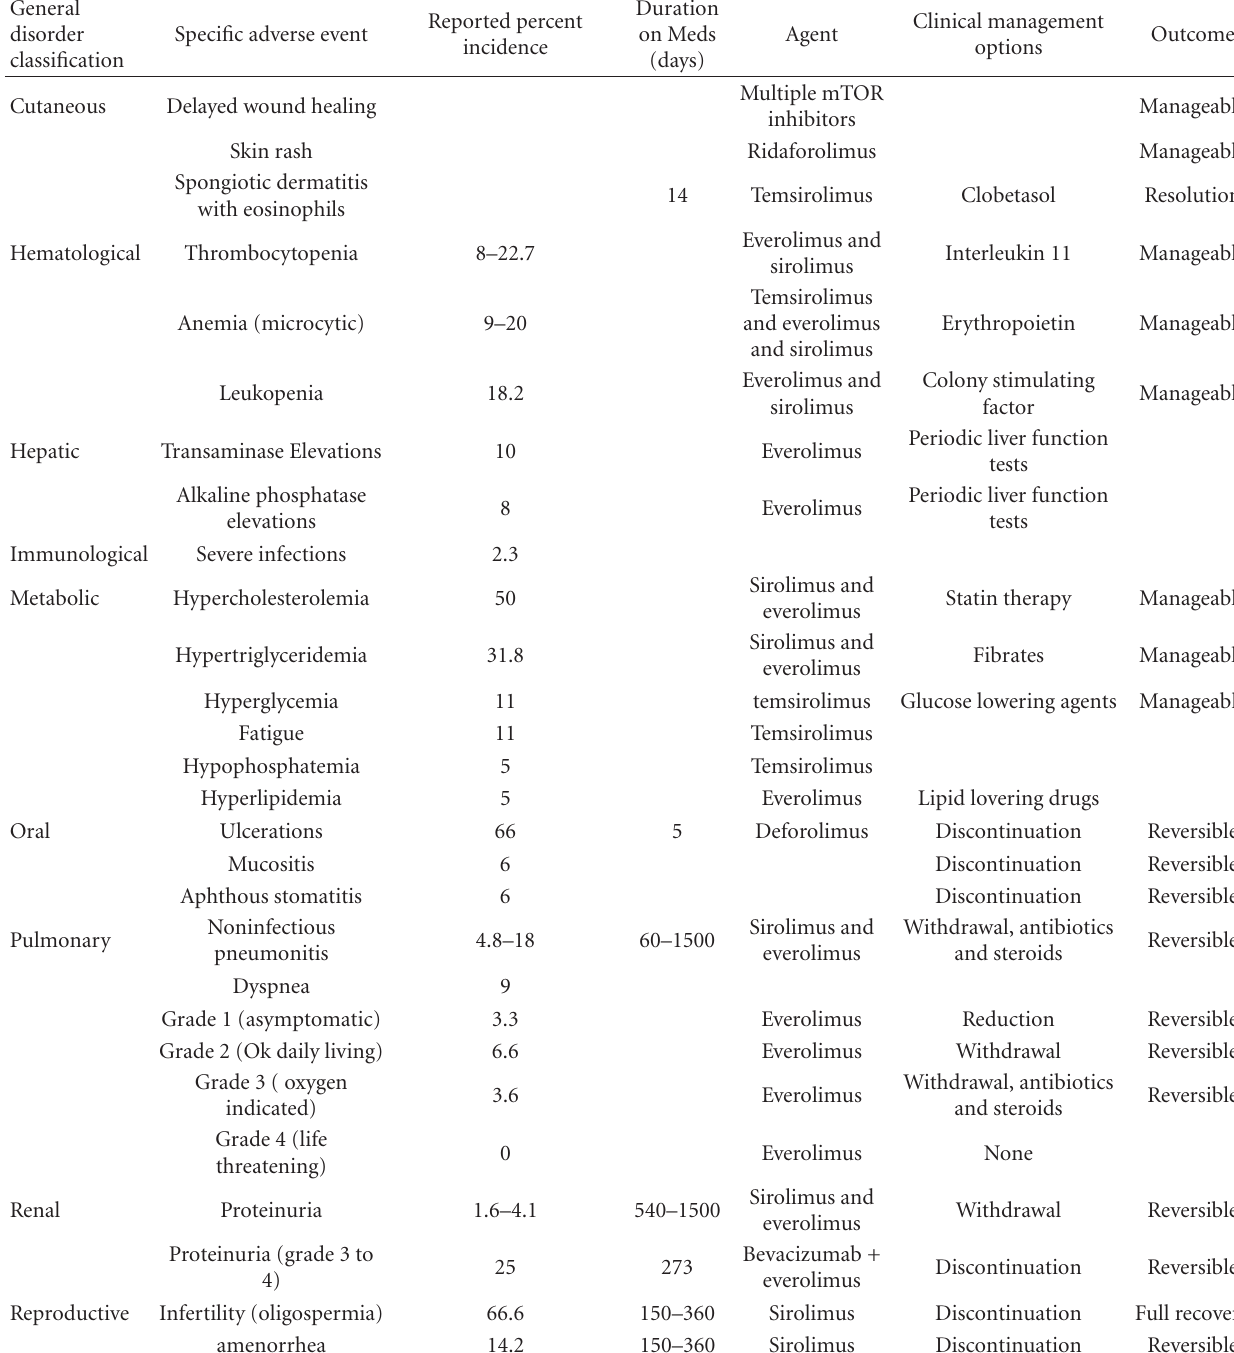
Table 3: Reported adverse e ff ects of mTOR